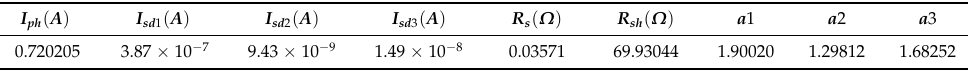
Table 3. An initial solution within the search ranges of nine